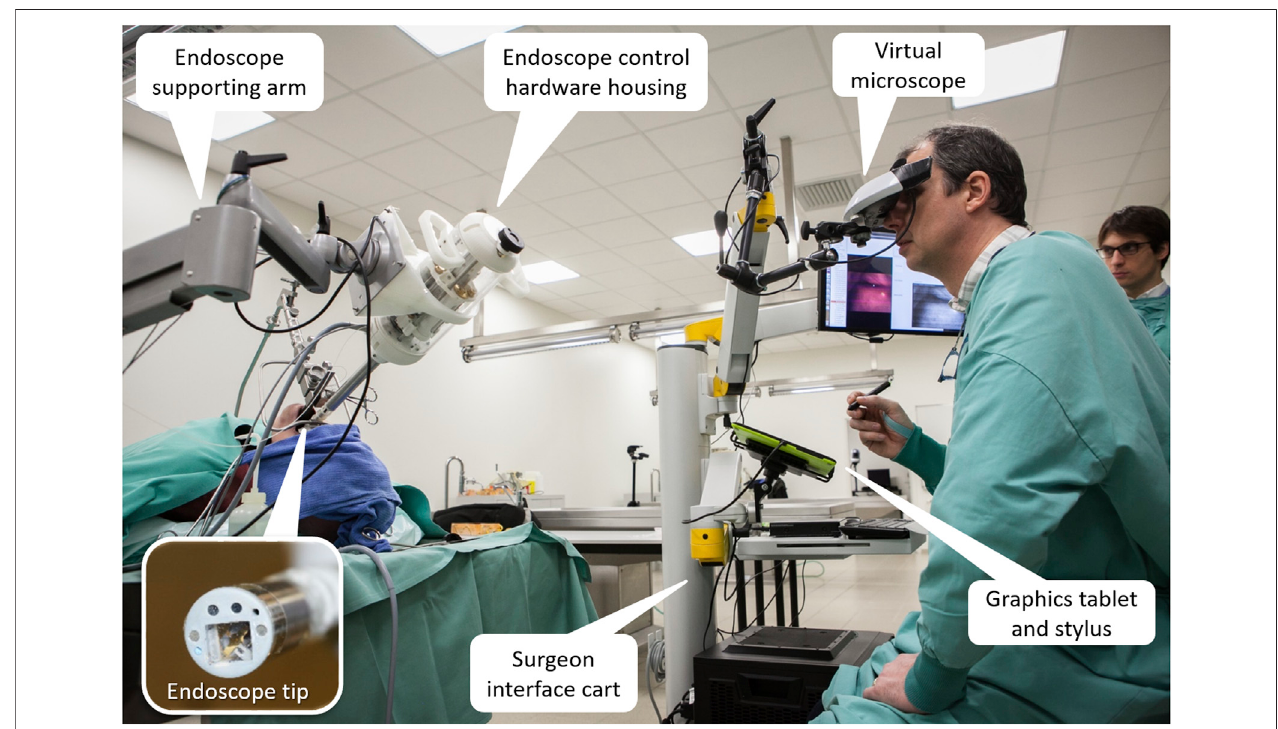
FIGURE 14 | The integrated µRALP surgical system prototype under evaluation in a human cadaver (Tavernier et al., 2017).